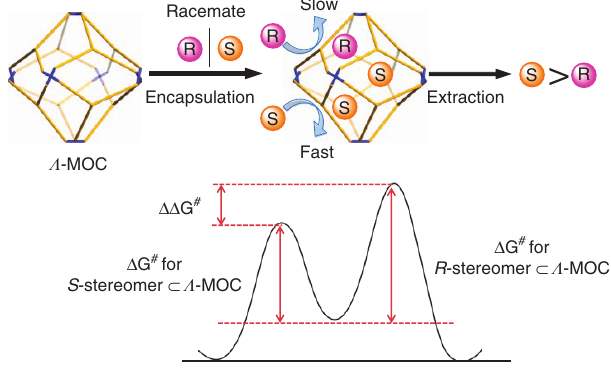
Figure 7 | Enantioseparation mechanism. A possible resolution process relying on guest exchange dynamics of atropisomers with homochiral L -MOC-16. D G # represents guest exchange energy